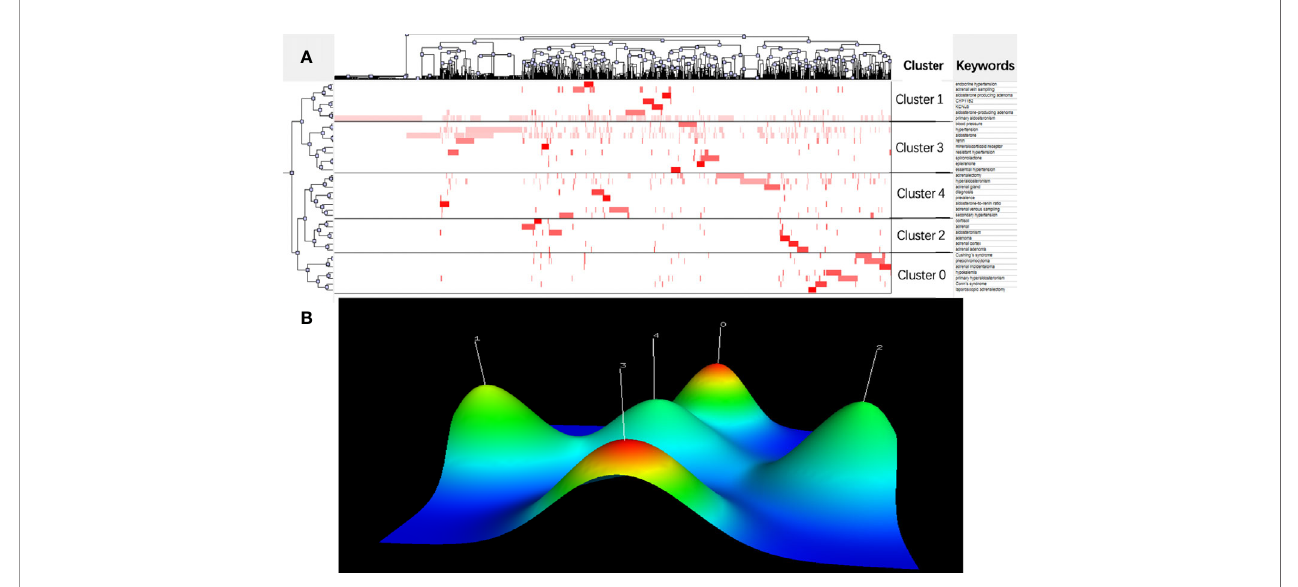
FIGURE 6 | Research hotspots in the fi eld of PA. (A) Visualized matrix of biclustering of highly frequent keywords in the research fi eld of PA. Color of each blot represented the frequency of occurrence of keywords in all literatures. (B) Mountain visualization of biclustering of highly frequent keywords in the research fi eld of PA. The height and color of the mountain are proportional to internal similarity and standard deviation of cluster (Blue: high deviation; Red: low deviation).